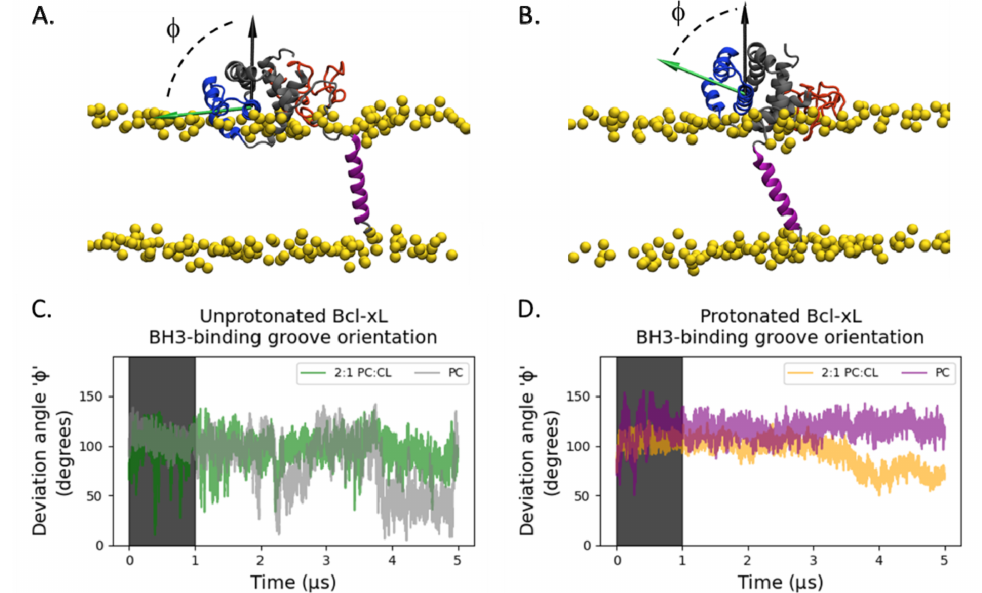
Figure 2. Accessibility of the Bcl-xL BH3-binding groove. ( A ) Configuration snapshot corresponding to a BH3-binding groove vector (green arrow) with a deviation angle from the membrane nor- mal (black arrow), φ , of greater than 90 ◦ , suggesting occlusion of the BH3-binding groove (color scheme as in Figure 1B). ( B ) Configuration snapshot corresponding to a groove vector with a shal- lower than 90 ◦ deviation angle from the membrane normal, suggesting an accessible BH3-binding groove (color scheme as in Figure 1B). BH3-binding groove deviation angle as a function of time for ( C ) unprotonated Bcl-xL in a 2:1 POPC:TOCL lipid bilayer (green) and POPC lipid bilayer (grey), and ( D ) protonated Bcl-xL in a 2:1 POPC:TOCL lipd bilayer (yellow) and POPC lipid bilayer (purple). The shaded regions (time < 1 µ s) represent the non-stationary portion of the trajectories and were not included in further analyses (see also Supplemental Figure